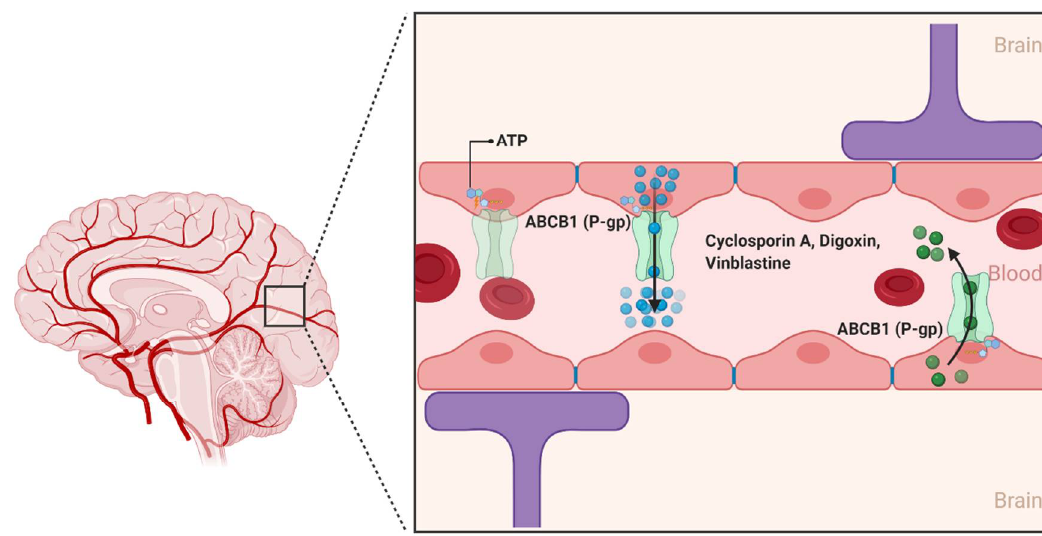
Figure 3. The ABCB1 transporter at the blood–brain interfaces. In the human brain, the ABCB1 transporter is found on the luminal membrane side and restricts the penetration of compounds in the brain by limiting the uptake of several substrate drugs. (Created with BioRender, accessed on 27 January 2021).